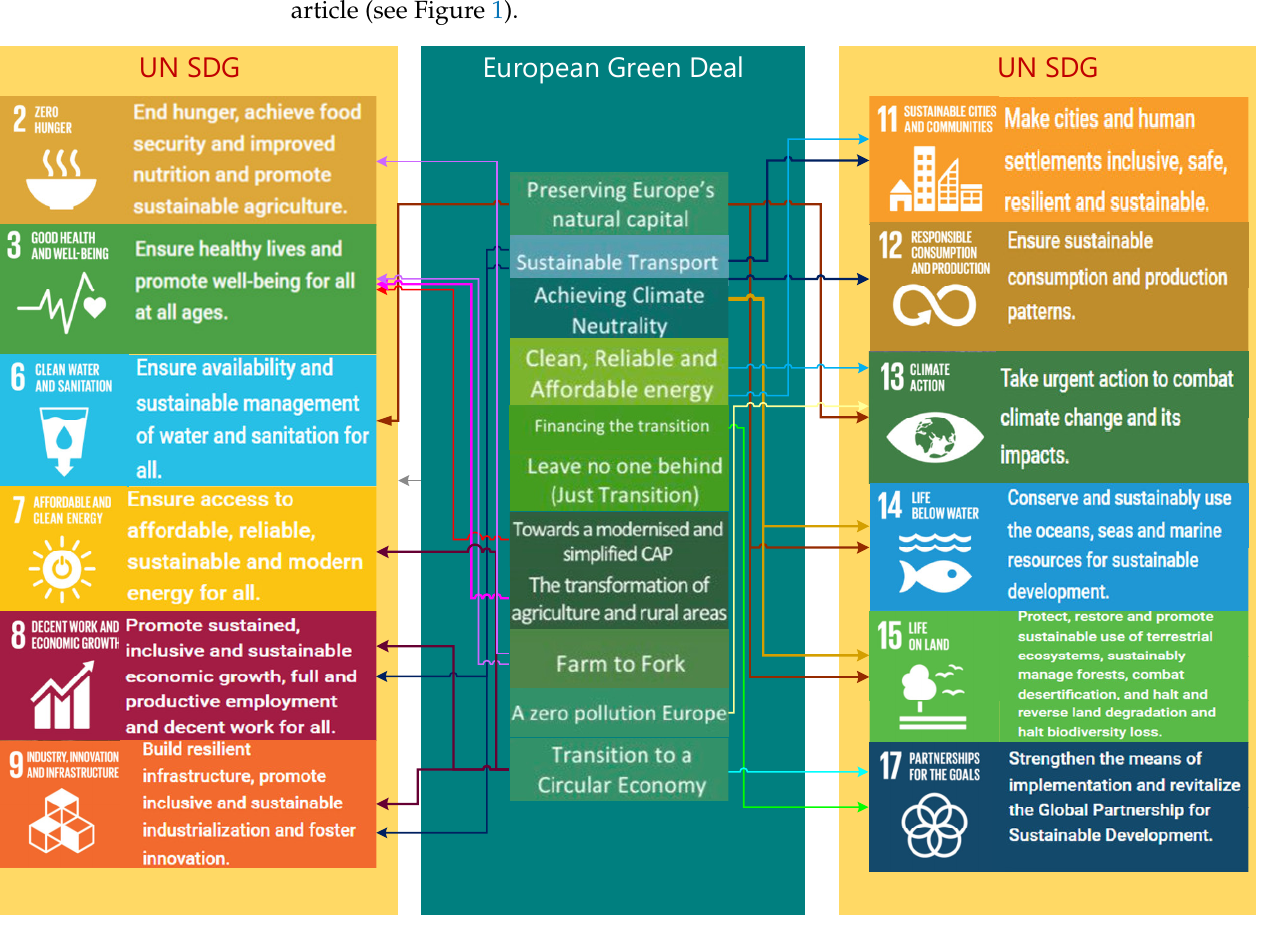
Figure 1. The link between the SDG targets and the EU green economy policy. Green Deal—SDG convergence is a way to streamline the achievement of the targets, with bi-directional cost allocation and transparency of results; the convergence method